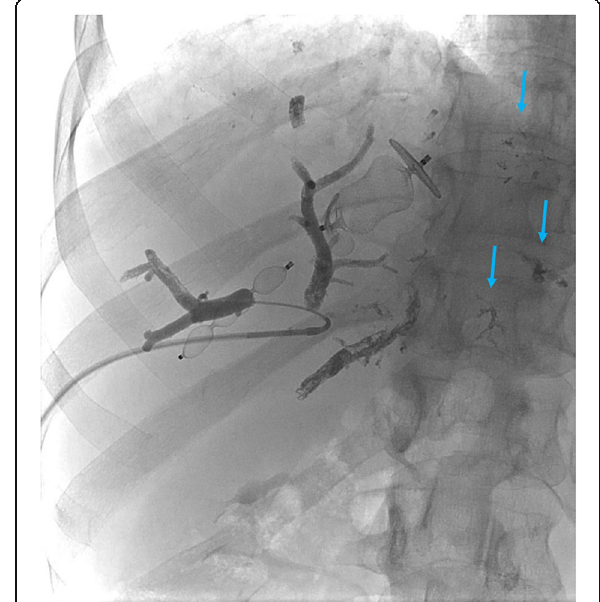
Fig. 3 Embolization of the portal vein after right hepatic vein embolization. Amplatzer plugs already inserted. Only 3rd order branches were filled with the Glubran 2 - Lipiodol mixture. Because of the very slow flow in the right portal vein some glue spilled to the other side (blue arrows) despite a selective microcatheter